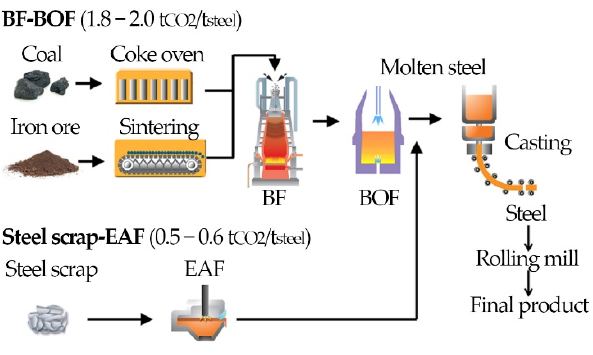
Figure 1. Main routes of steel production [4].